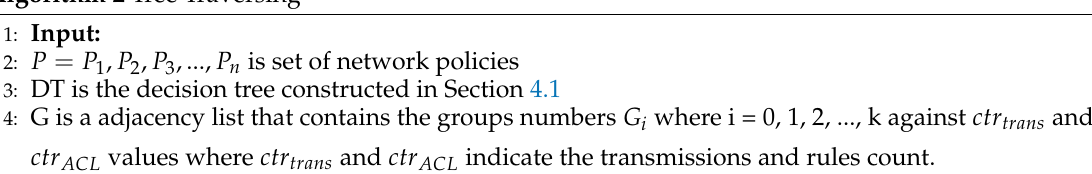
Algorithm 2 Tree